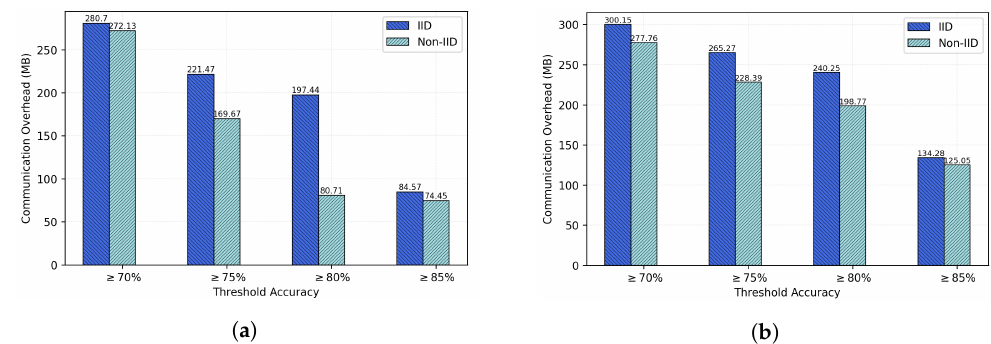
Figure 12. The communication overhead for 100 rounds for the two LEAF datasets. The top plot presents the results produced for CelebA dataset, while the bottom plot depicts the results generated on FEMNIST dataset. ( a ) CelebA; ( b )